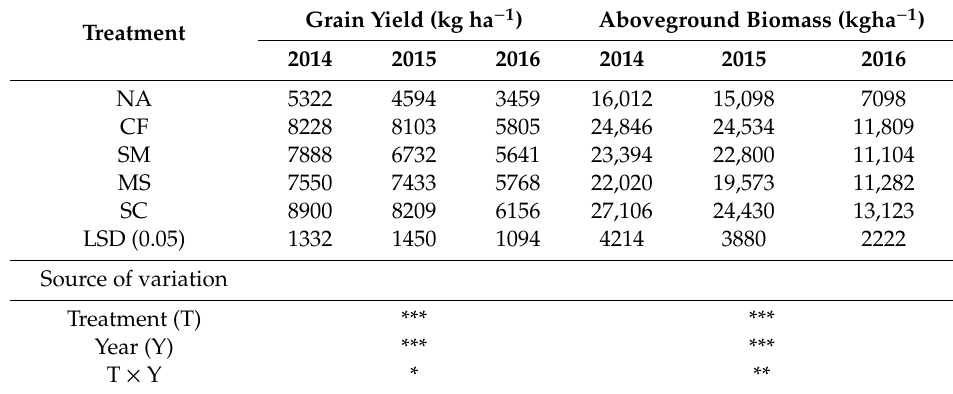
Table 4. Yield and aboveground biomass of maize by soil amendment treatment in 2014, 2015, and 2016. Grain Yield (kg ha − 1 ) Treatment